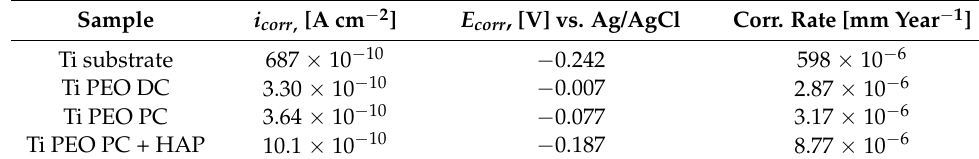
Table 2. Corrosion parameters were estimated from the Tafel extrapolation method.